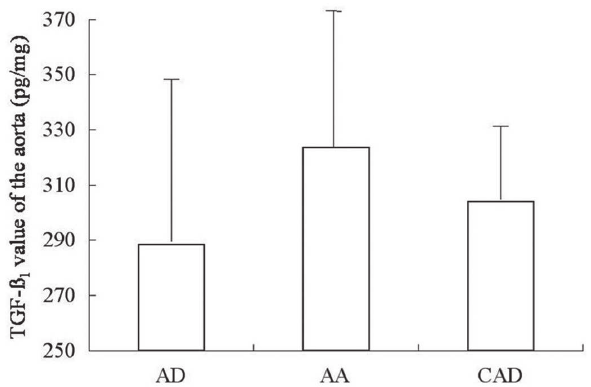
Fig. 6. Plasma TGF-ß level by ELISA. AD: aortic dissection; AA: 1 aortic aneurysm; CAD: coronary artery disease. P < 0.025 by rank sum